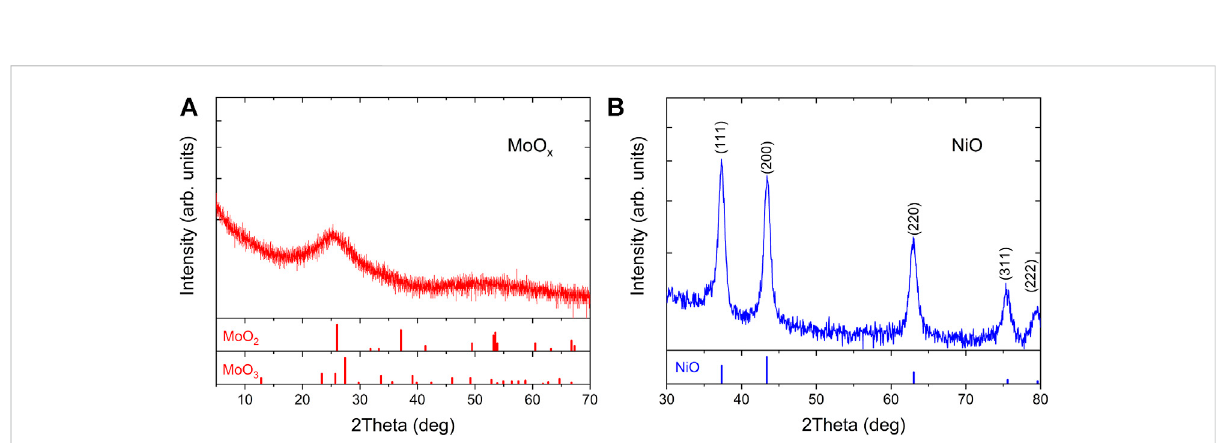
FIGURE 6 XRD pattern of 100 nm fi lms of (A) MoOx and (B) NiO on soda lime glass (SLG). Reference XRD data for MoO 2 , MoO 3 and NiO are shown underneath the XRD with JPDCS card ID 65-5787, 35-0609 and 04-0,835 respectively.